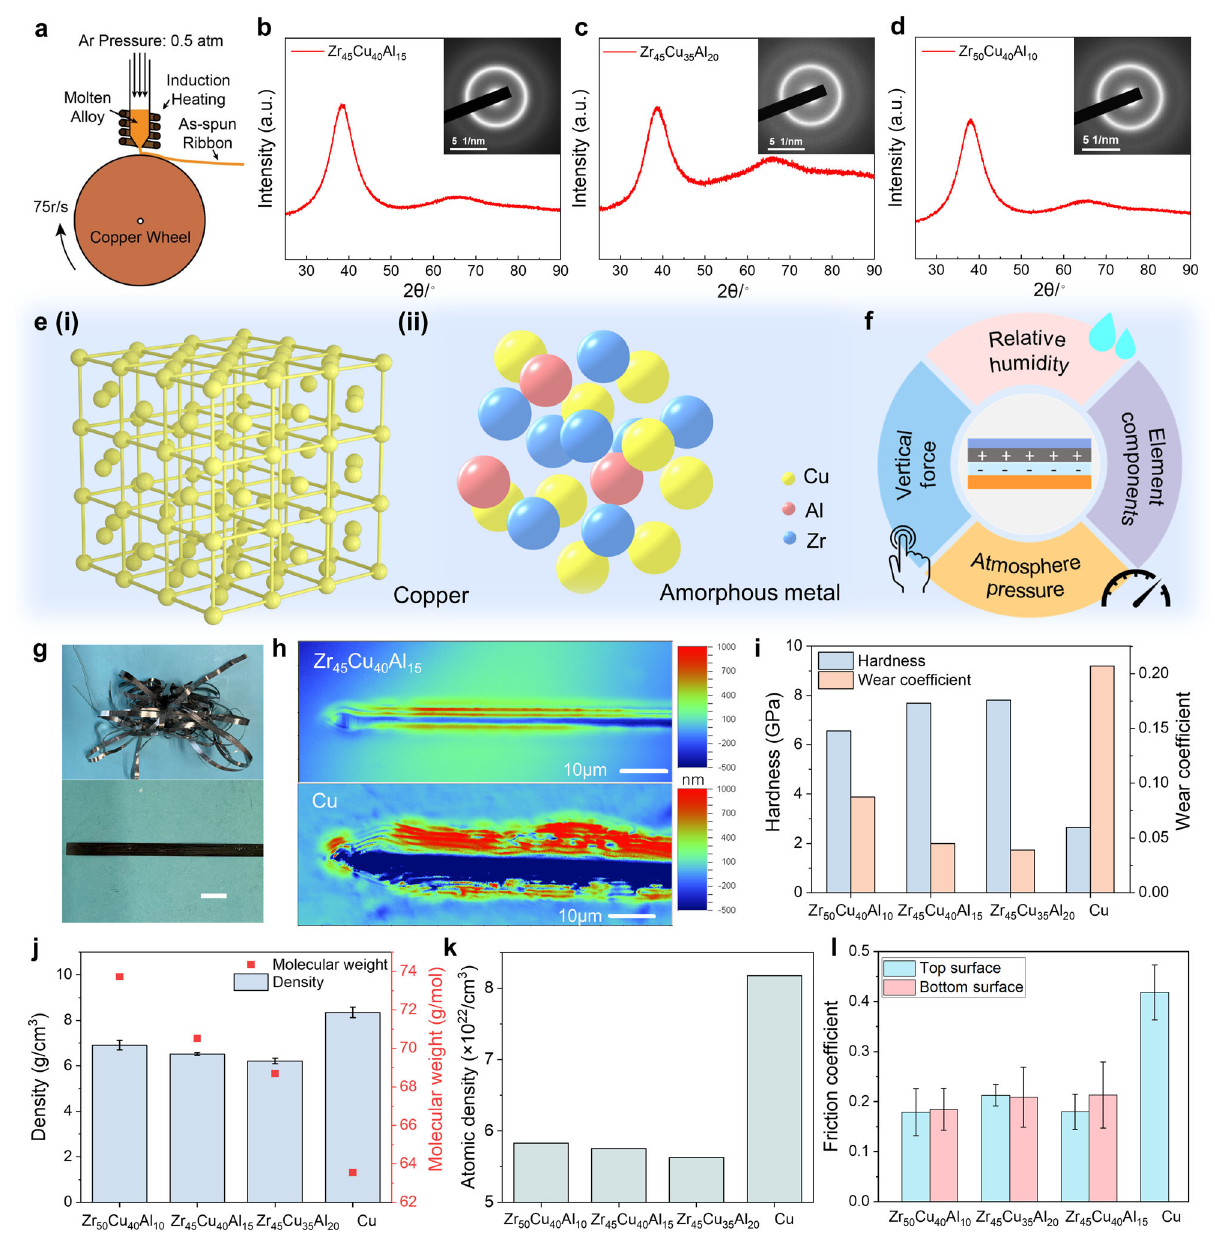
Fig.1|Preparationandmaterialcharacterizationofthemetallicglassmaterial. a Fabrication of the metallic glass ribbon. X-ray diffraction patterns of b Zr 45 Cu 40 Al 15 , c Zr 45 Cu 35 Al 20 and d Zr 50 Cu 40 Al 10 and corresponding diffraction images as insets. e Atomic structure of ( i ) Cu and (ii) metallic glass. f Factors for evaluatingtheoutputperformanceofTENGbasedonmetallicglass. g Photographs of the as-received Zr 45 Cu 40 Al 15 ribbon. Scale bar=1cm. h Optical surface pro fi ler